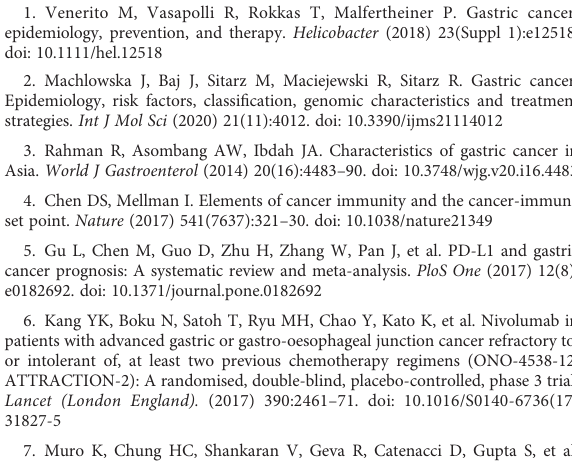
SUPPLEMENTARY FIGURE 1 Comparation of (A) high resolution computerized tomography (CT), (B) hematoxylin-eosin staining in lesions, (C) esophagogastroscopy results between patients pretherapy and after all cycles of treatment. SUPPLEMENTARY FIGURE 2 Variation of immunity indicators during cycles of treatment. SUPPLEMENTARY FIGURE 3 (A) A rank of the features based on the AUC value to the response calculated by fi ltering algorithm; (B) Correlation analysis of selected features age, CD4, IFN g , TNF a and IL-10. (C) comparation analysis of the classi fi cation error of six FSL machine-learning classi fi ers. (D) ROC analysis of six FSL machine-learning classi fi ers. The area under the ROC curve AUC, the receiver operating characteristic curve